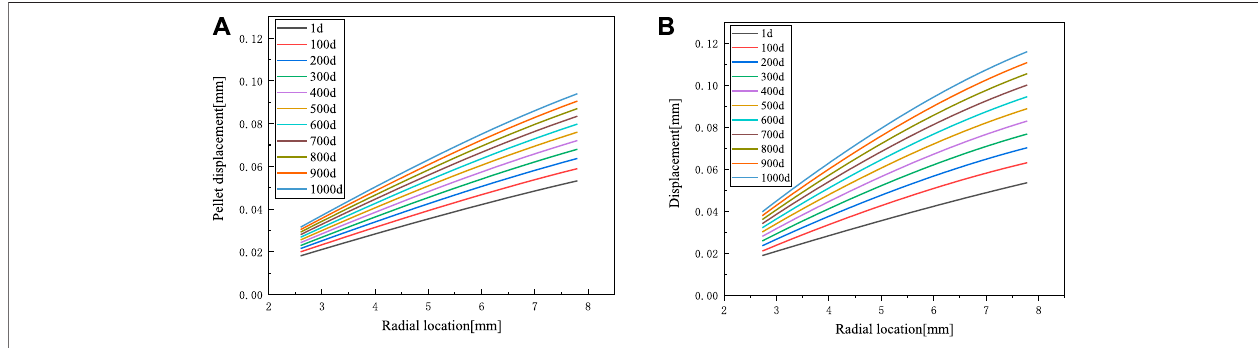
FIGURE 7 | Pellet displacement calculation results. (A) the code calculation result. (B) COMSOL calculation result.